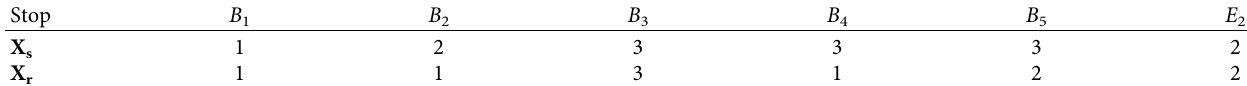
Table 7: Obtained particle radius vectors.